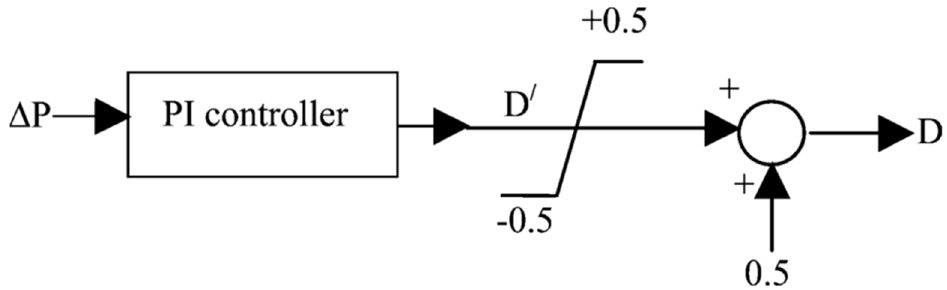
Figure 4. DC-DC chopper duty cycle Figure 4. DC ‐ DC chopper duty cycle control.